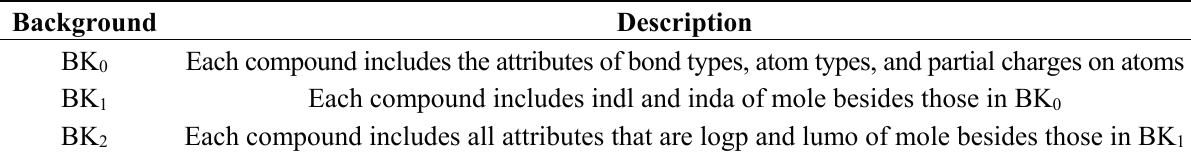
Figure 5. FCM structure of Mutagenesis in BK 2 . Table 2. Three kinds of background of Mutagenesis.